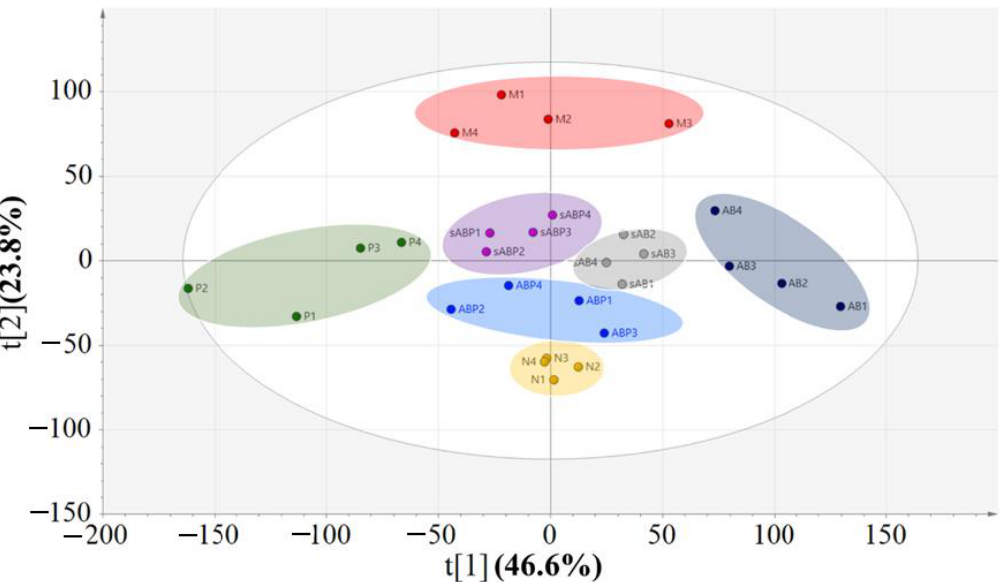
Figure 5. Score plot of PCA model of normal group, model group, and differently treated groups. N1-N4 represents normal group, M1 – M4 represents model group, P1 – P4 represents E2-treated group, AB1 – AB4 represents polysaccharide knockout component of crude AB-treated group, sAB1 – sAB4 represents polysaccharide knockout component of salt-processed AB-treated group, ABP1 – ABP4 represents polysaccharide component of crude AB-treated group, sABP1 – sABP4 represents polysaccharide component of salt-processed AB-treated group.